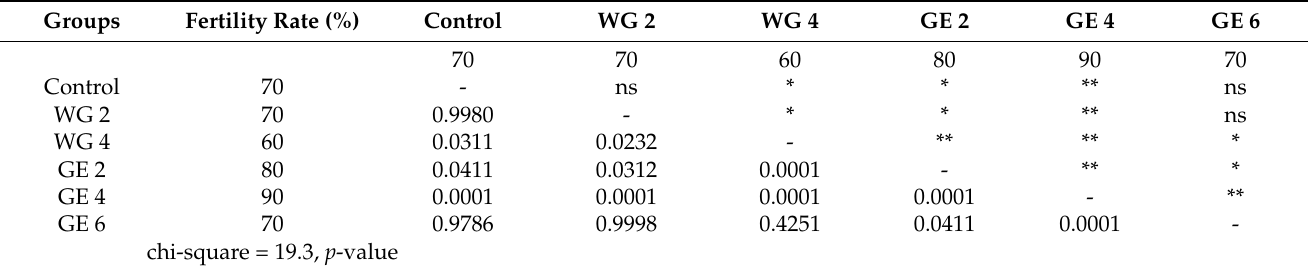
Table 5. Fertility rate in cryopreserved semen with Holothurioidea extract